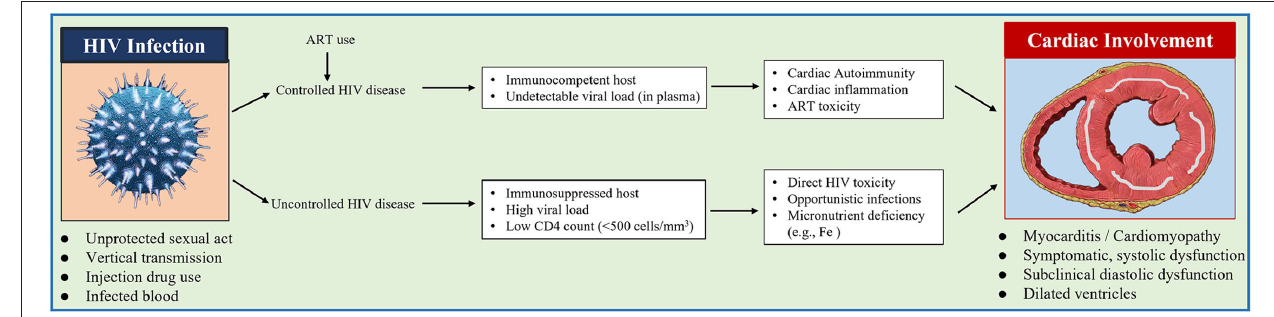
FIGURE 4 | Diagram shows the proposed pathogenic mechanism of cardiac involvement in patients with HIV